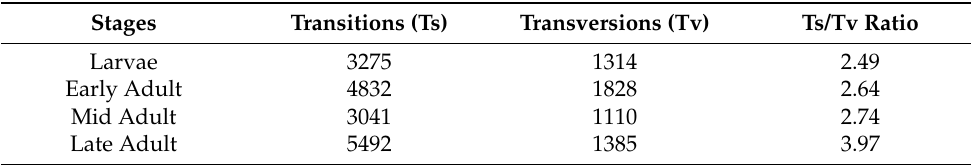
Table 2. Single-nucleotide polymorphism substitutions in Kerria lacca